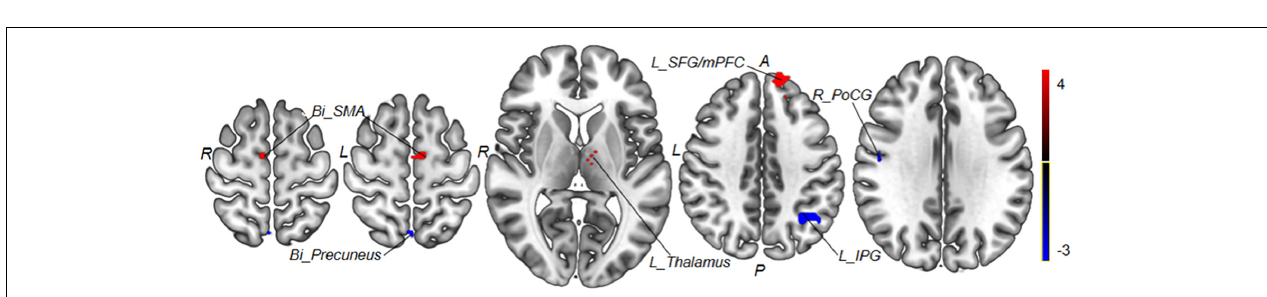
FIGURE 7 | Prediction performance for taVNS treatment. (A) The feature selection curve reflected the changing prediction-outcome correlation following the increased number of features, and the highest correlation coefficient is 0.411. (B) The histogram showed the result of permutation test with highest correlation coefficient, reflecting the stability of the SVR model ( p < 0.001).